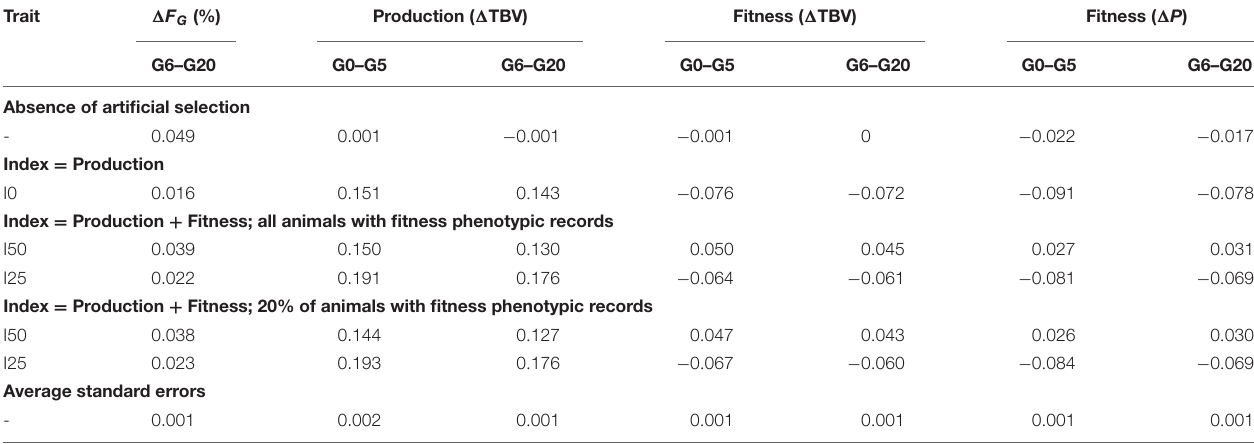
TABLE 4 | Optimum contribution of both sexes for minimization of inbreeding (MI) under random mating: results are the observed rate of genomic inbreeding ( (cid:49) F G ), the rates of genetic improvement ( (cid:49) TBV ) in productivity and fitness and the rate of phenotypic change ( (cid:49) P ) in fitness after accounting for inbreeding depression and for selection indices emphasizing 0, 25, and 50% on fitness (I0, I25, I50); the constraint in the rate of gain for the index was